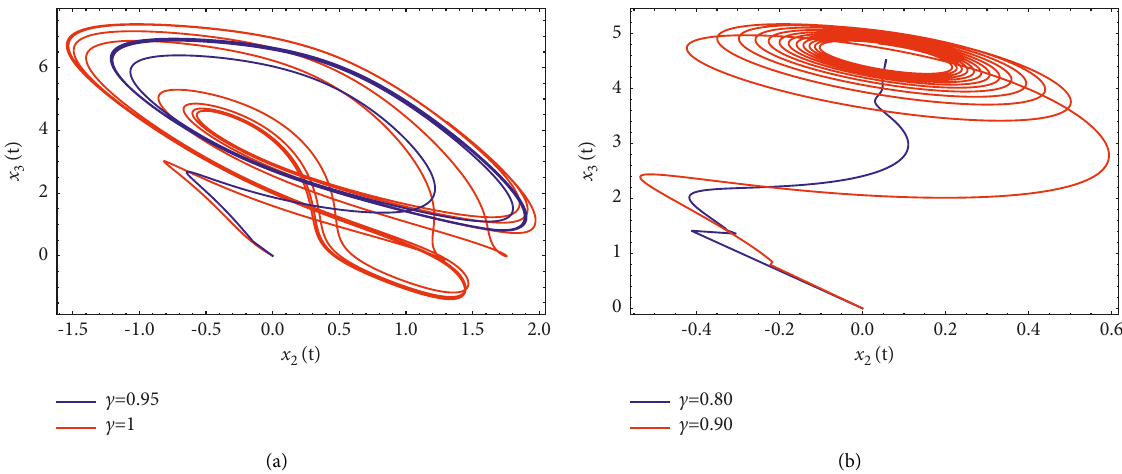
Figure 10: Dynamics of coexisting multiple attractors’ for gradient β orders. (a) State variables x 2 versus x 3 ; (b) state variables x 2 versus x 3